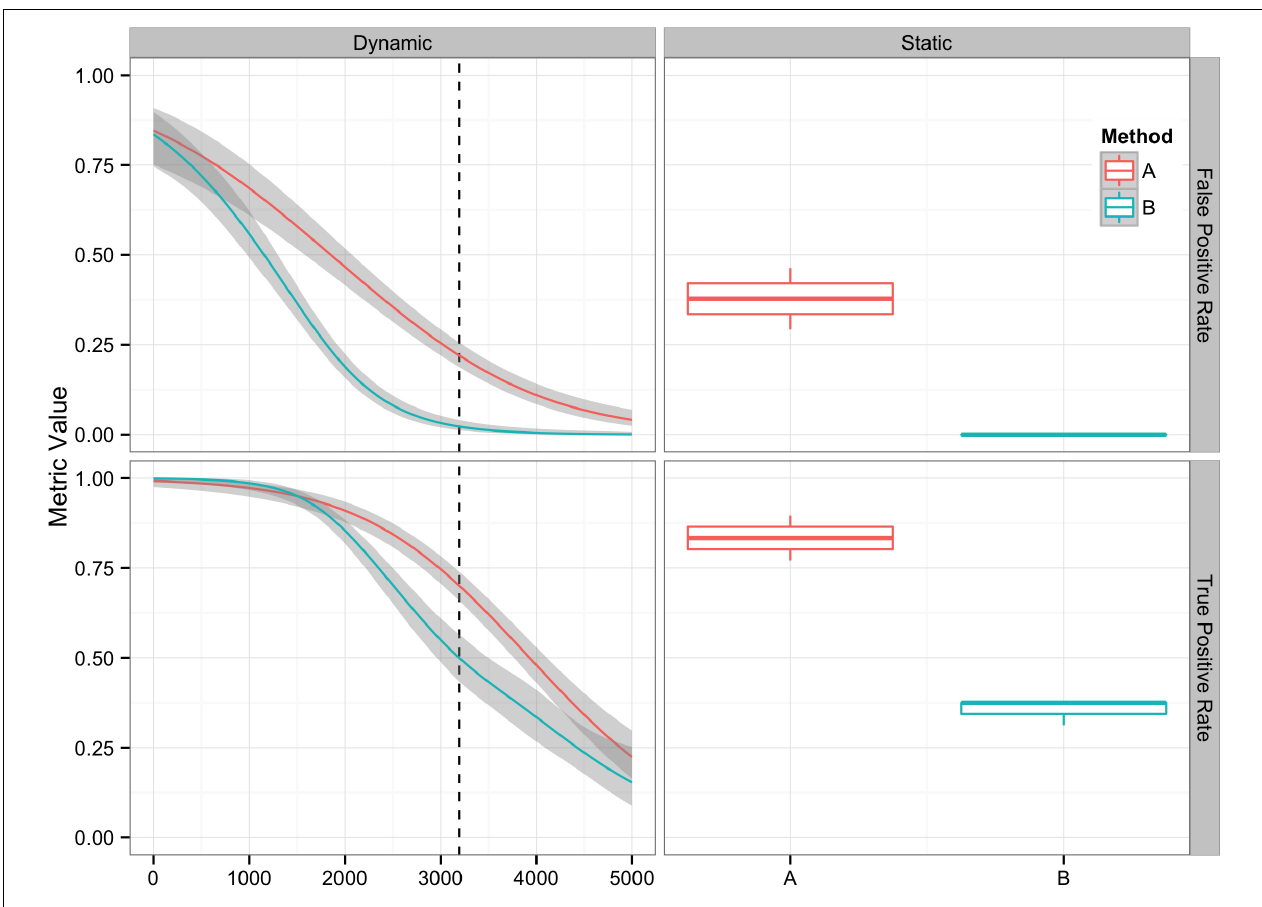
FIGURE 4 | Comparison of two variant calling algorithms using two of the performance metrics in Table1, true positive rate and false positive rate, calculated from contingency tables over a range of quality score thresholds (left) and a fixed quality score threshold (right). Methods A (red) and B (teal) indicate two different variant calling methods. Left: A smoothing function (generalized additive model) was used to summarize the